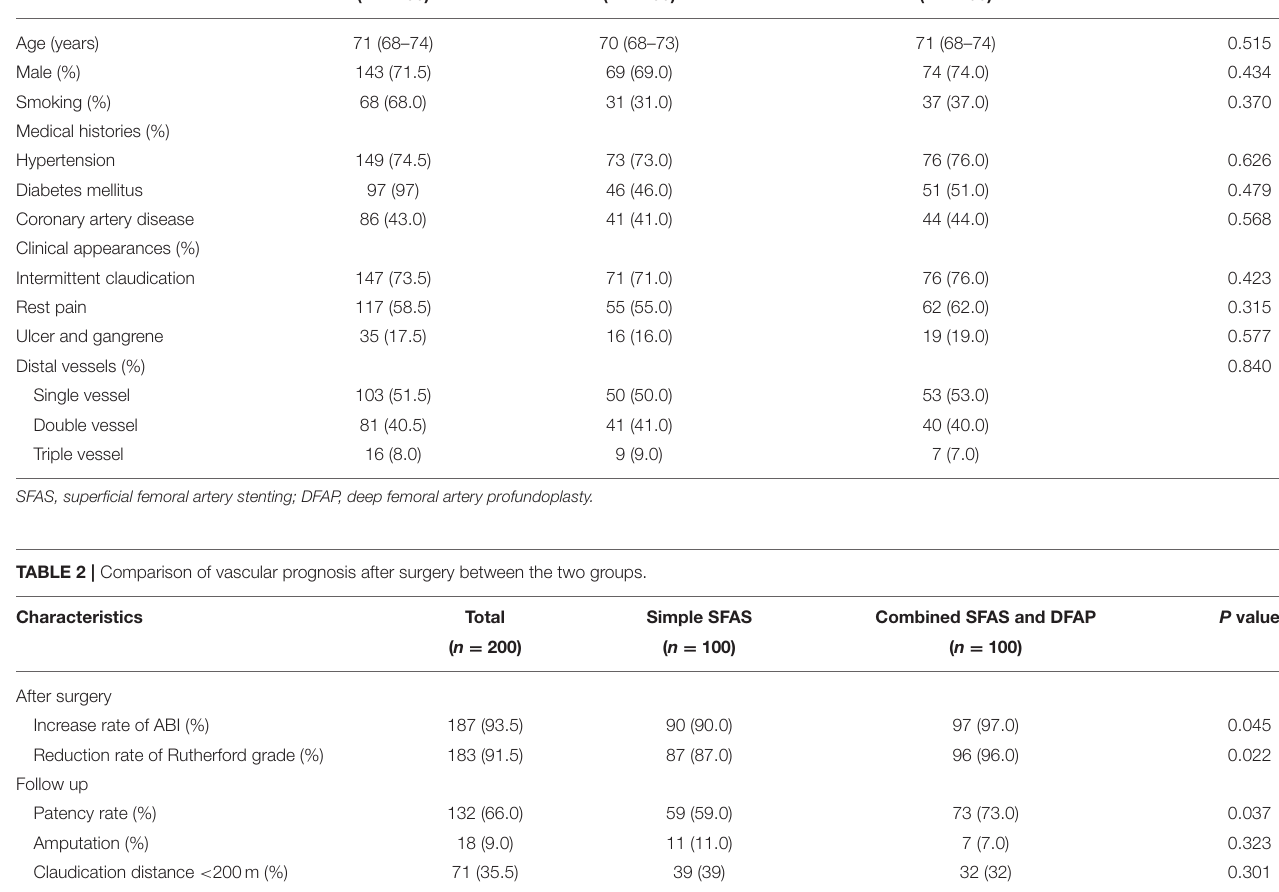
TABLE 1 | Comparison of baseline characteristics before surgery between the two groups. Characteristics